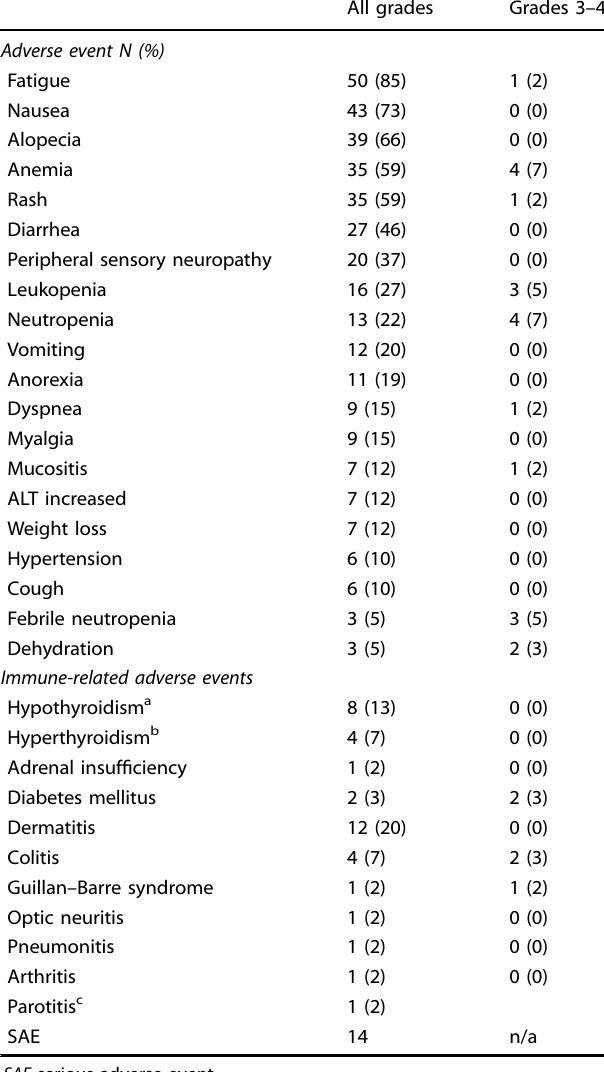
Table 3. Treatment-related adverse events occurring in ≥ 10% of patients, or grades 3 – 4 occurring in ≥ 2% of